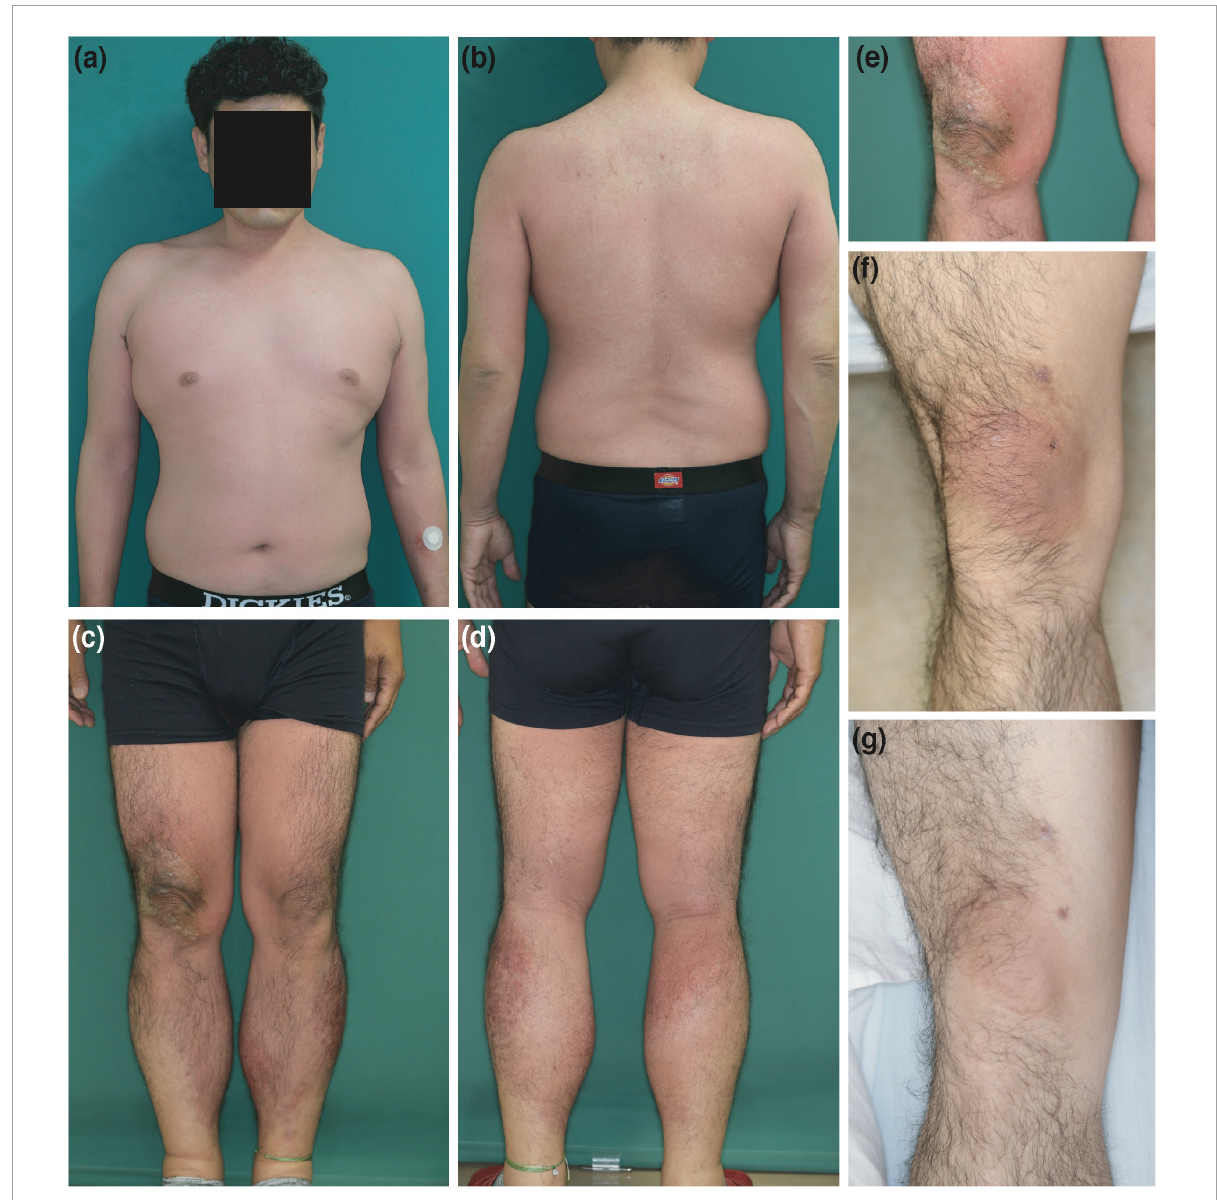
FIGURE1 Clinical features. (a–e) Erythematous skin eruptions that first appeared on the right knee and subsequently spread all over the body, except for the upper back and the ends of the extremities, at the first consultation. (f) Clearly demarcated erythema on the right knee only after the intravenous injection (as is) with the mixed agent containing chondroitin sulfate sodium and sodium salicylate. (g) Clearly demarcated erythema on the right knee after intravenous injection with chondroitin sulfate sodium (as